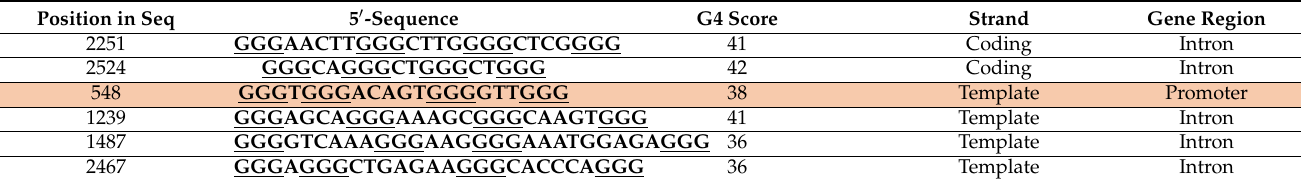
Table 3. Top predicted quadruplex sequences in the S100P gene, as found using the QGRS Mapper program (https://bioinformatics.ramapo.edu/QGRS/index.php), accessed on 12 June 2022. The G4 score, as defined in [43], is a measure of the likelihood of the sequence forming a stable quadruplex under physiological conditions. Only those sequences with a G-score >35 are listed here. G-tracts are underlined. The highlighted sequence, in the S100P promoter, is discussed further